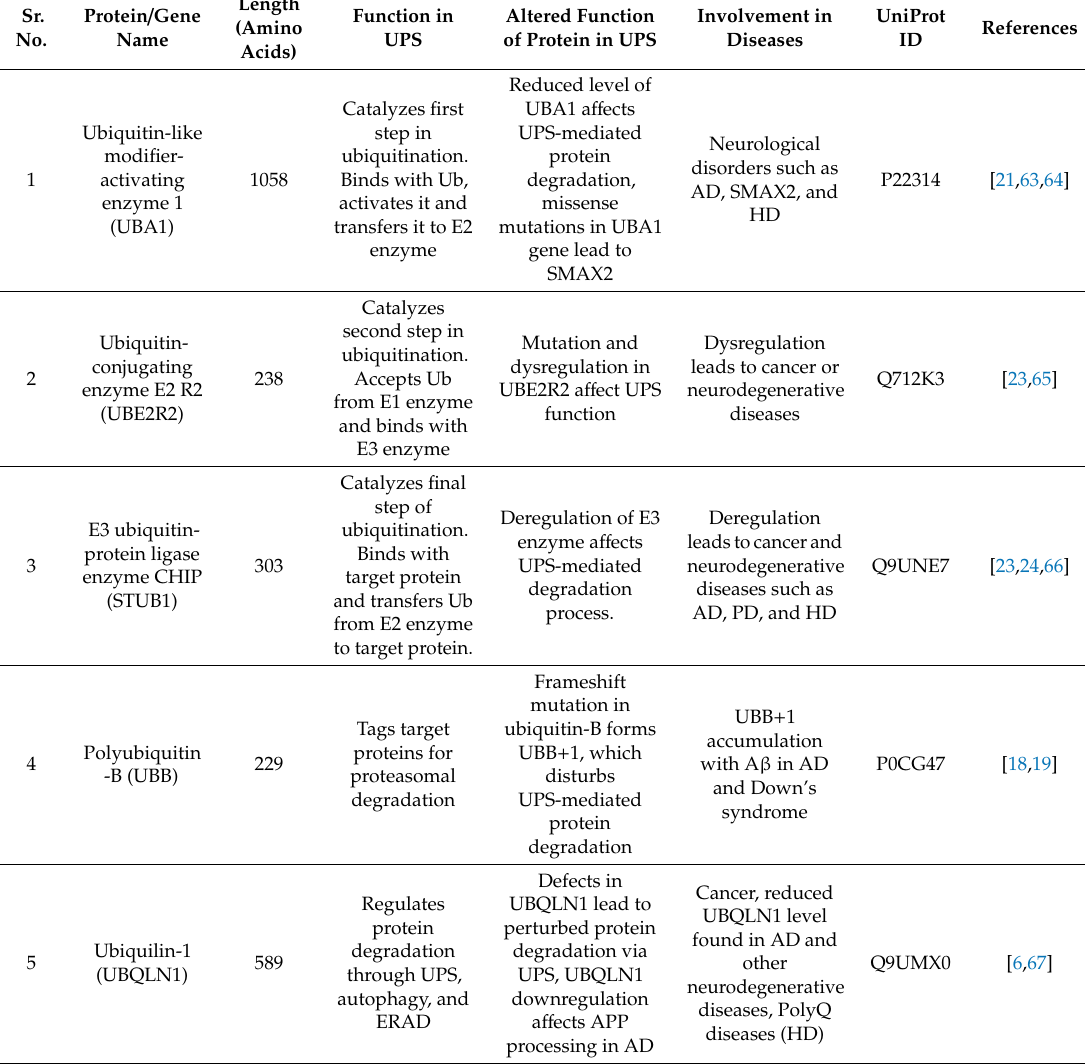
Table 1. Proteins involved in the ubiquitin proteasomal system (UPS). Sr.